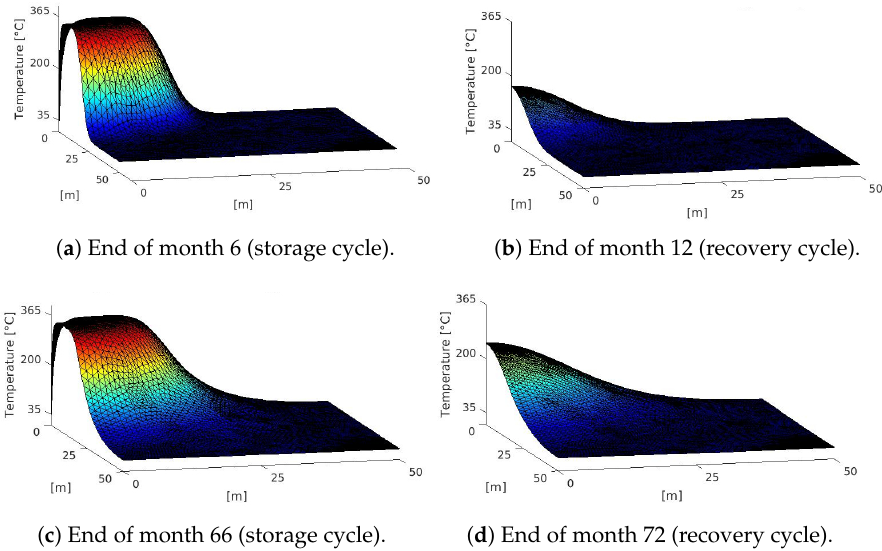
Figure 3. The temperature distribution inside the aquifer at different times: ( a , b ) correspond to the storage cycles; ( c , d ) correspond to the recovery